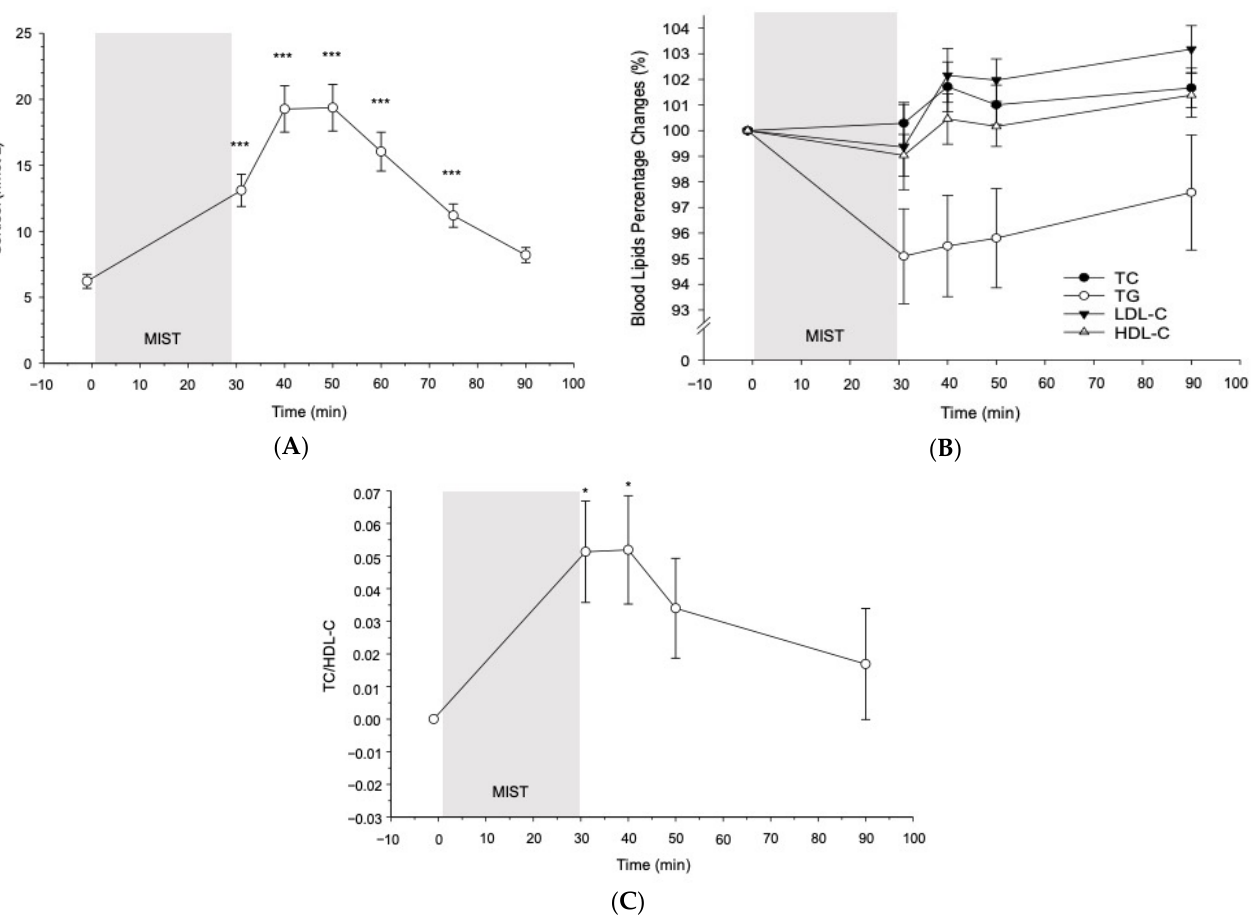
Figure 1. ( A – C ). Cortisol and blood lipid changes in response to the MIST. Values are means ± SEM . ( A ) Cortisol. ( B ) Percentage changes from baseline to post-stress in TC, TG, LDL-C, and HDL-C. ( C ) TC/HDL-C ratio changes from baseline in response to MIST. Asterisks indicate significant differences between baseline and the respective post-stress levels * p < 0.05; *** p < 0.001.